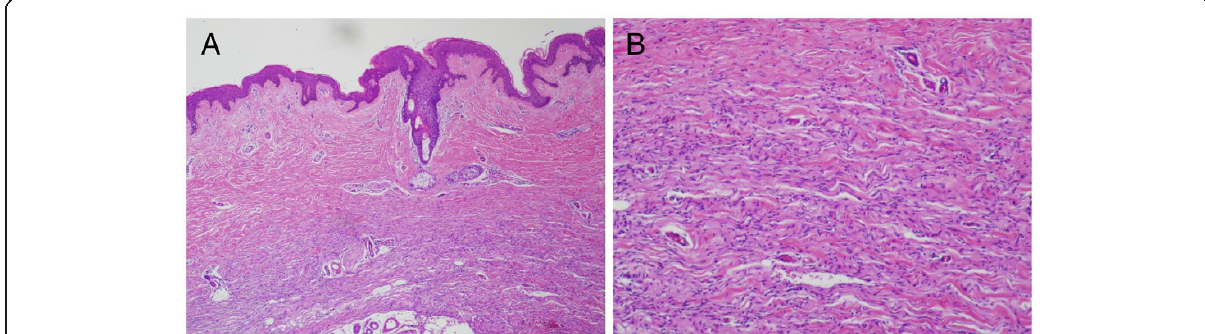
Figure 2 (A) Biopsy revealed a monomorphic spindle cell proliferation in the dermis and subcutaneous fat, with the spindle cells aligned horizontally to the epidermis section (hematoxylin-eosin, original magnification: ×100). (B) The nuclei of the spindle cells were thin, elongated and often wavy, with little pleomorphism (hematoxylin-eosin, original magnification: